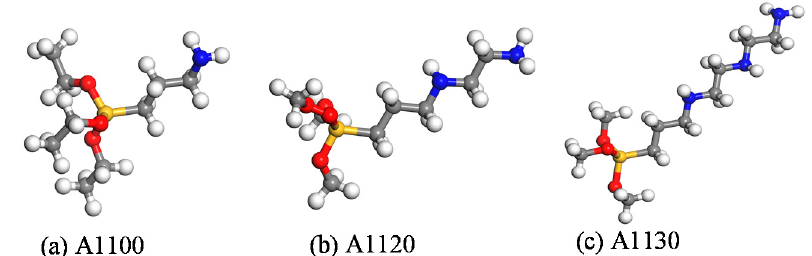
Figure 2. Three different chain length aminosilane coupling agents; ( a ) 3-aminopropyltriethoxysilane; ( b ) N -(2-aminoethyl)-3-aminopropyltrimethoxysilane; ( c ) 3-[2-(2-amino-ethyl) Ethylamino)ethylamino] propyl-trimethoxysilane.